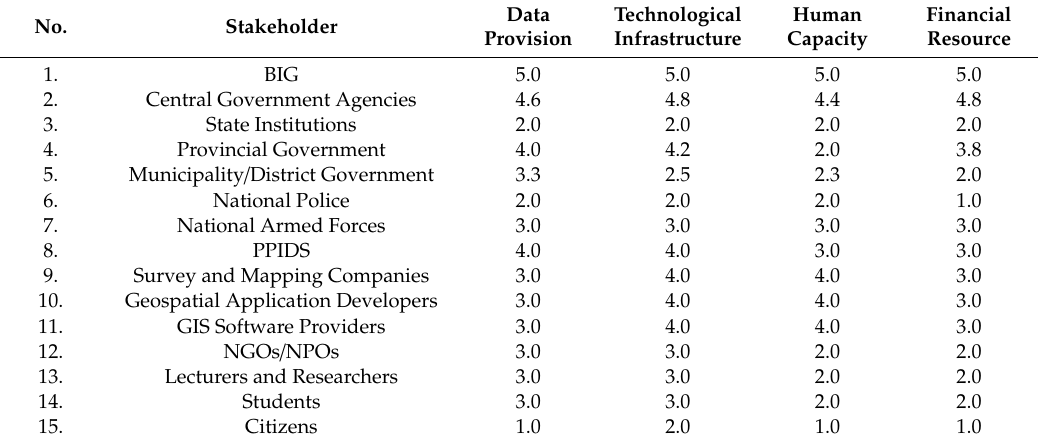
Table A3 describes the average values of the four NSDI features from the questionnaire surveys. Table A3. Average Likert scale values of the national spatial data infrastructure (NSDI) stakeholders’